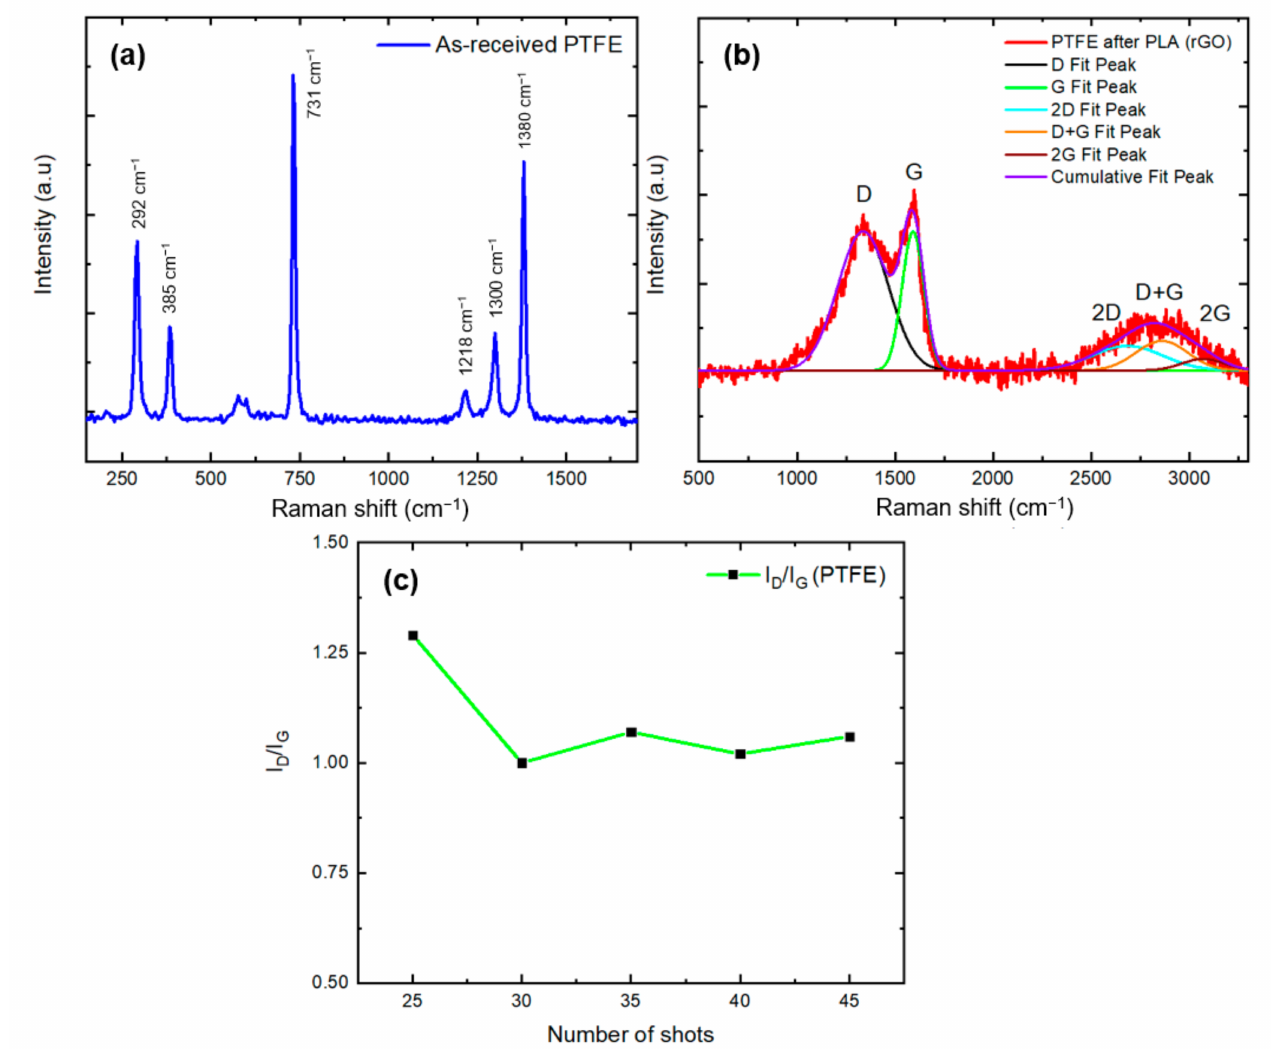
Figure 4. Raman spectra of ( a ) PTFE before PLA and ( b ) PTFE after 30 shots of the ArF laser at 0.9 ± 0.1 J·cm − 2 . ( c ) I D /I G values versus the number of laser